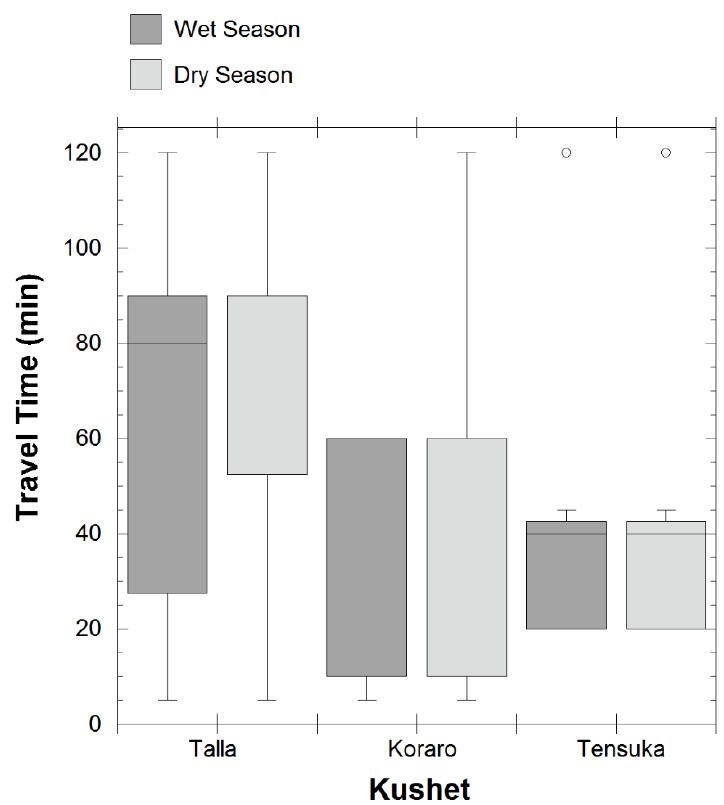
Figure 4. Water collection travel time by Kushet and season. The boxplots represent the 25th, 50th, and 75th percentiles with the upper whiskers marking 1.5 the interquartile range from the corresponding quartile for each dataset.